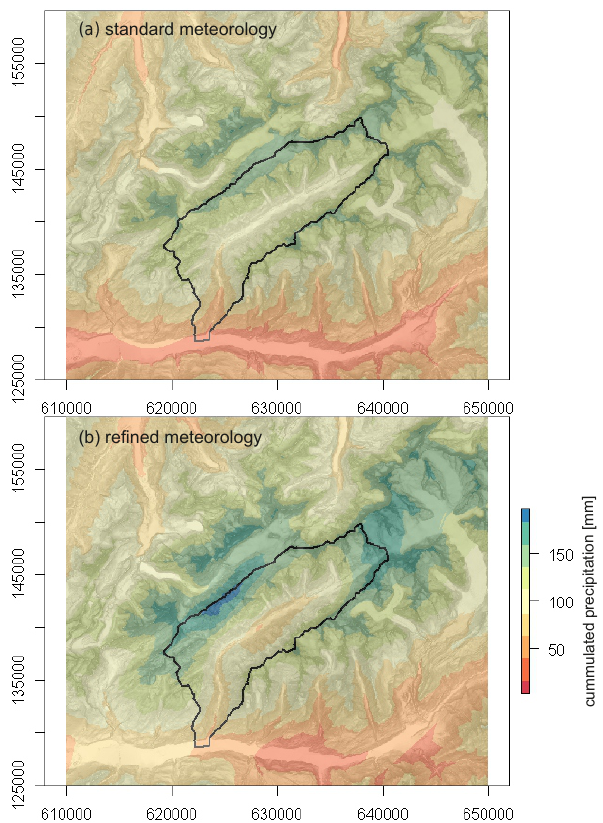
Figure 8. Accumulated liquid precipitation from 9 October 14:00UTC to 10 October 20:00UTC, as regionalized by the hy- drological model using the inverse distant and height regression ap- proaches with the official meteorological stations and the SLF Gan- degg station (cp. Fig. 1), and using (a) the refined meteorology with all available meteorological stations with a correction function and (b) a fixed southwest–northeast interpolation orientation following the